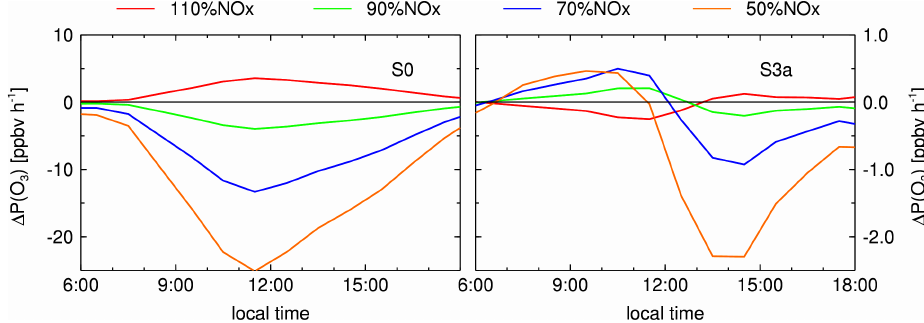
Fig. 10. Hourly 1 P(O 3 ) due to NO x changes under S0 and